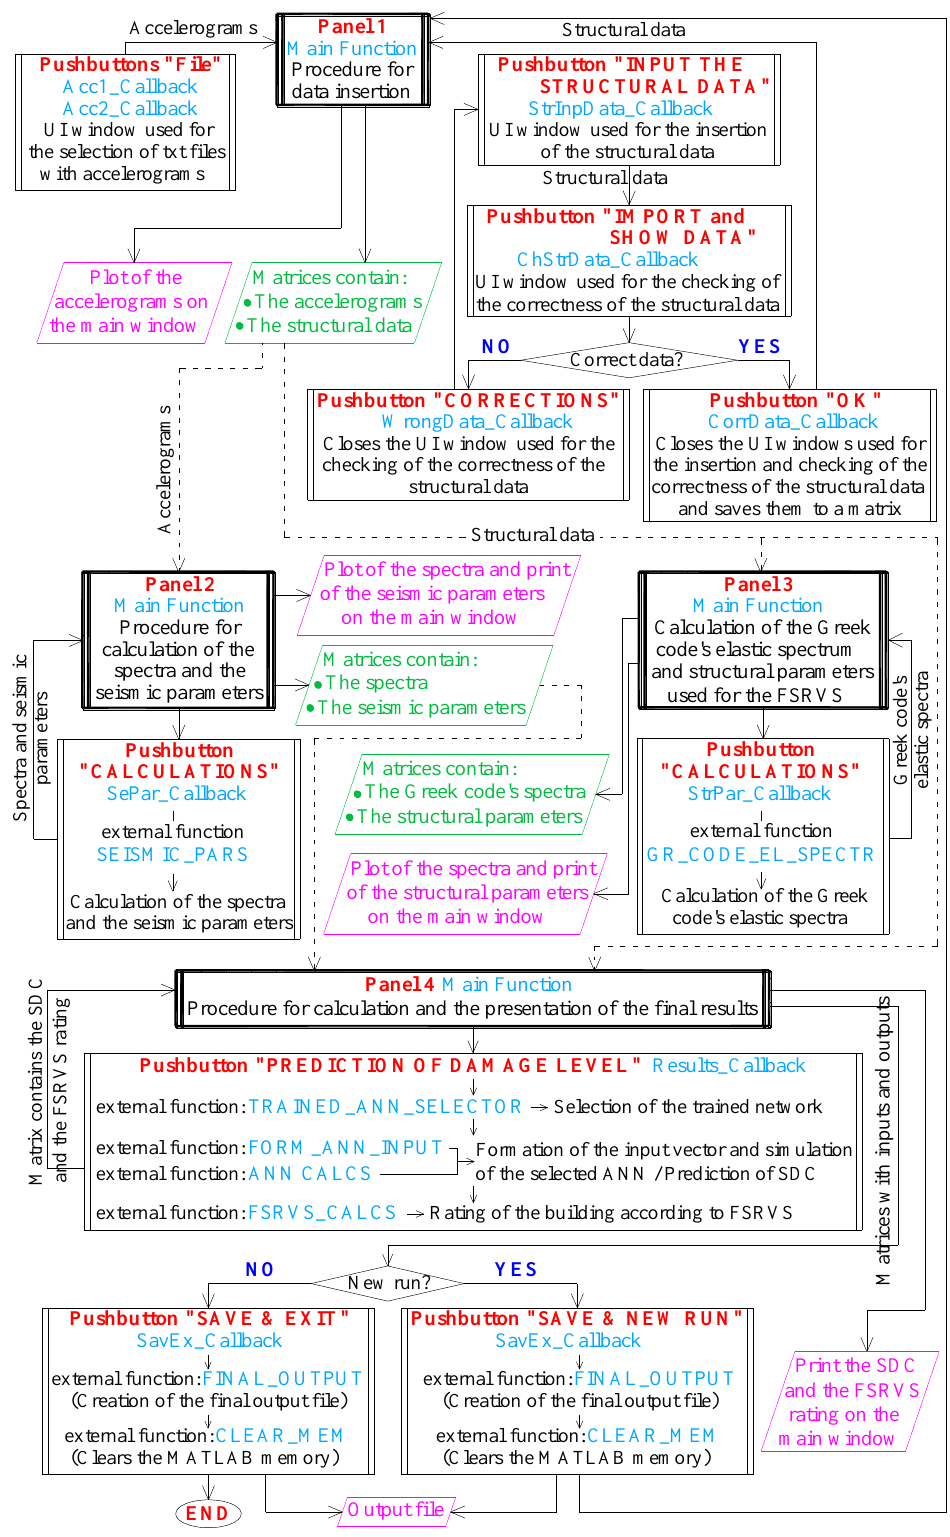
Figure 13. Brief flow chart of the source code of the developed software application.